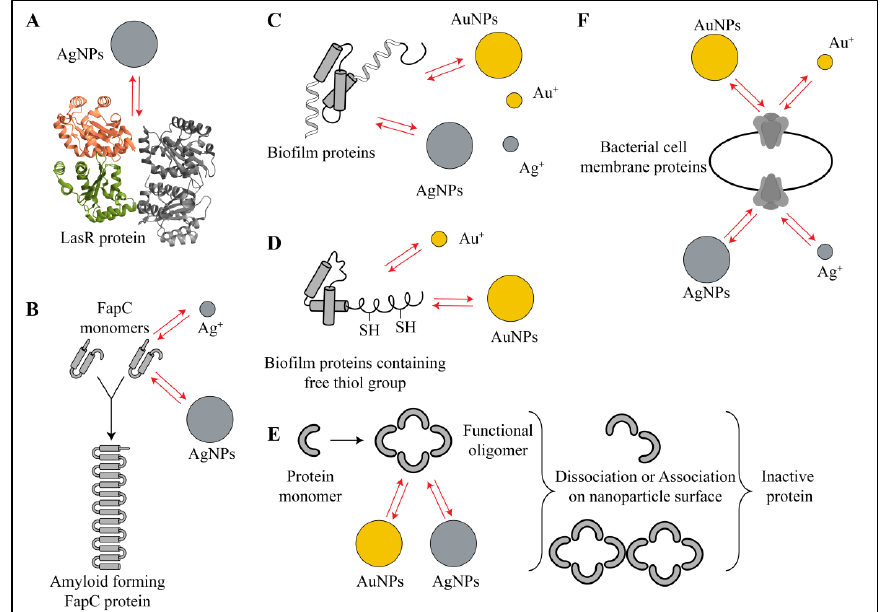
Figure 3. Schematic representation of various interactions between gold or silver nanoparticles